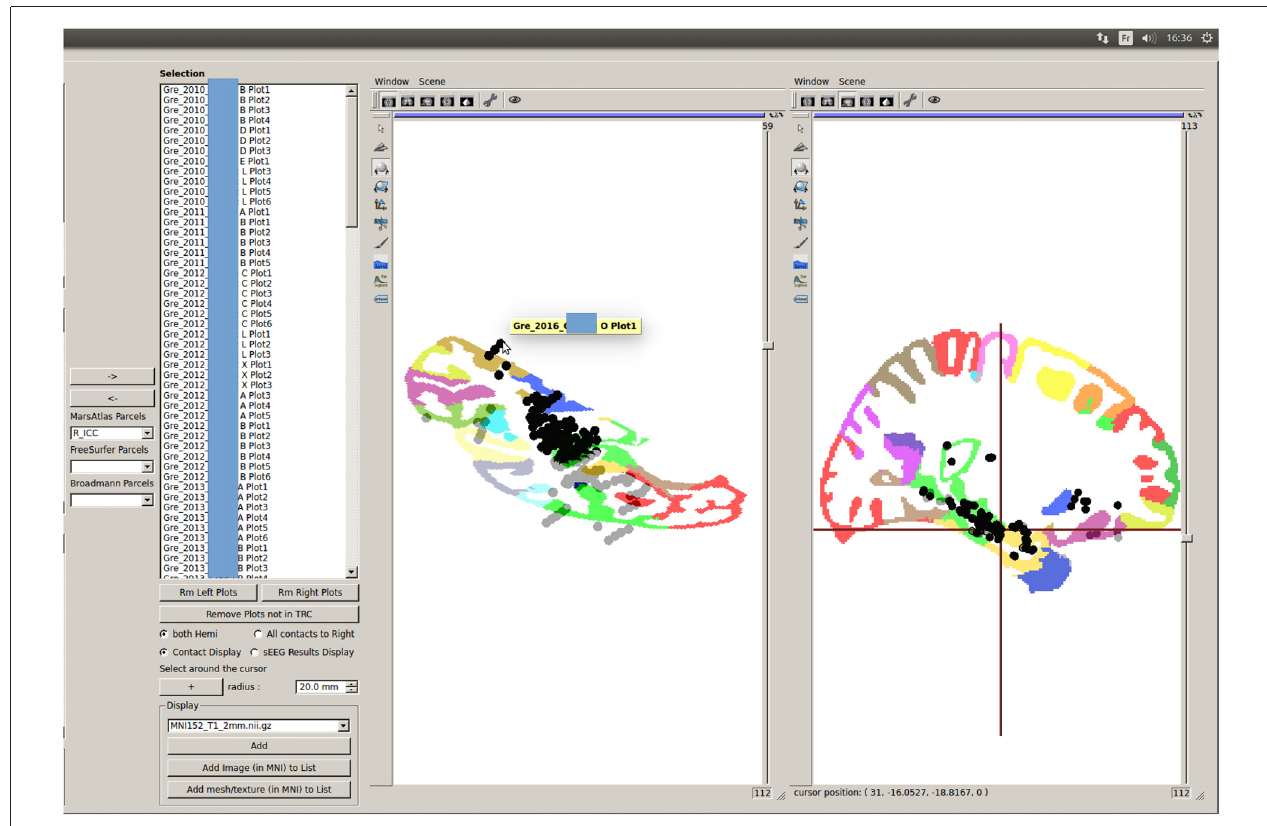
FIGURE 12 | Quick MarsAtlas parcellation quality control based on GroupDisplay of contacts labeled as being from the same parcel. Outliers can be easily identified : here, some contacts from one patient are very far from the ICC region of the template, despite being labeled as ICC contacts. The atlas labeling from this patient must be corrected by tuning the atlas registration parameters for optimized results. An automatic outlier detection tool is available (see Figure 13